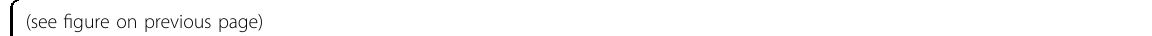
Fig. 2 Microglia proliferation after nerve injury consists of a Myc -dependent early phase and a Myc -independent late phase. a Representative fl ow-cytometry scatter plots to assess microglia proliferation in lumbar spinal cord after sciatic nerve injury. The proportion of proliferating Ki67 ( + ) microglia in Cx3cr1-creER-yfp/ + ; + / + animals increased 2 and 3 days after nerve injury. b Quanti fi cation of fl ow cytometry highlights the time course of nerve injury-induced microglia proliferation. In control Cx3cr1-creER-yfp/ + ; + / + animals, microglia proliferation started at day 2, persisted through day 3, and then gradually reduced to termination by day 7 after nerve injury. In contrast, the early phase of microglia proliferation on day 2 after nerve injury was completely abolished in Cx3cr1-creER-yfp/ + ; Myc fl / fl cKO animals, but the late phase and the termination phase of microglia proliferation remained intact in cKO animals. c , d Representative Ki67 IHC staining ( c ) and the associated quanti fi cation ( d ) of lumbar dorsal cord microglia after nerve injury. Animals with Myc deletion from adult microglia had signi fi cantly less Ki67 ( + ) proliferating microglia in lumbar dorsal cord (DC) 2 days, but not 3 days, after nerve injury. The arrowheads point to the Ki67 ( + ) microglia, and the dashed lines outline the dorsal lumbar cord. Microglia are identi fi ed by YFP staining. e Differential expression volcano plot of pseudobulk scRNA-Seq analysis. The G2/M-phase microglia between day 2 and day 3 after nerve injury displayed distinct gene expression pro fi les. Analyses are two-way ANOVA with Sidak ’ s multiple- comparison test, n = 4 – 6, means ± SEM, * P < 0.05, *** P < 0.001, **** P < 0.0001, ns, not signi fi cant. The statistical analysis in b shows the difference between Myc cKO and control